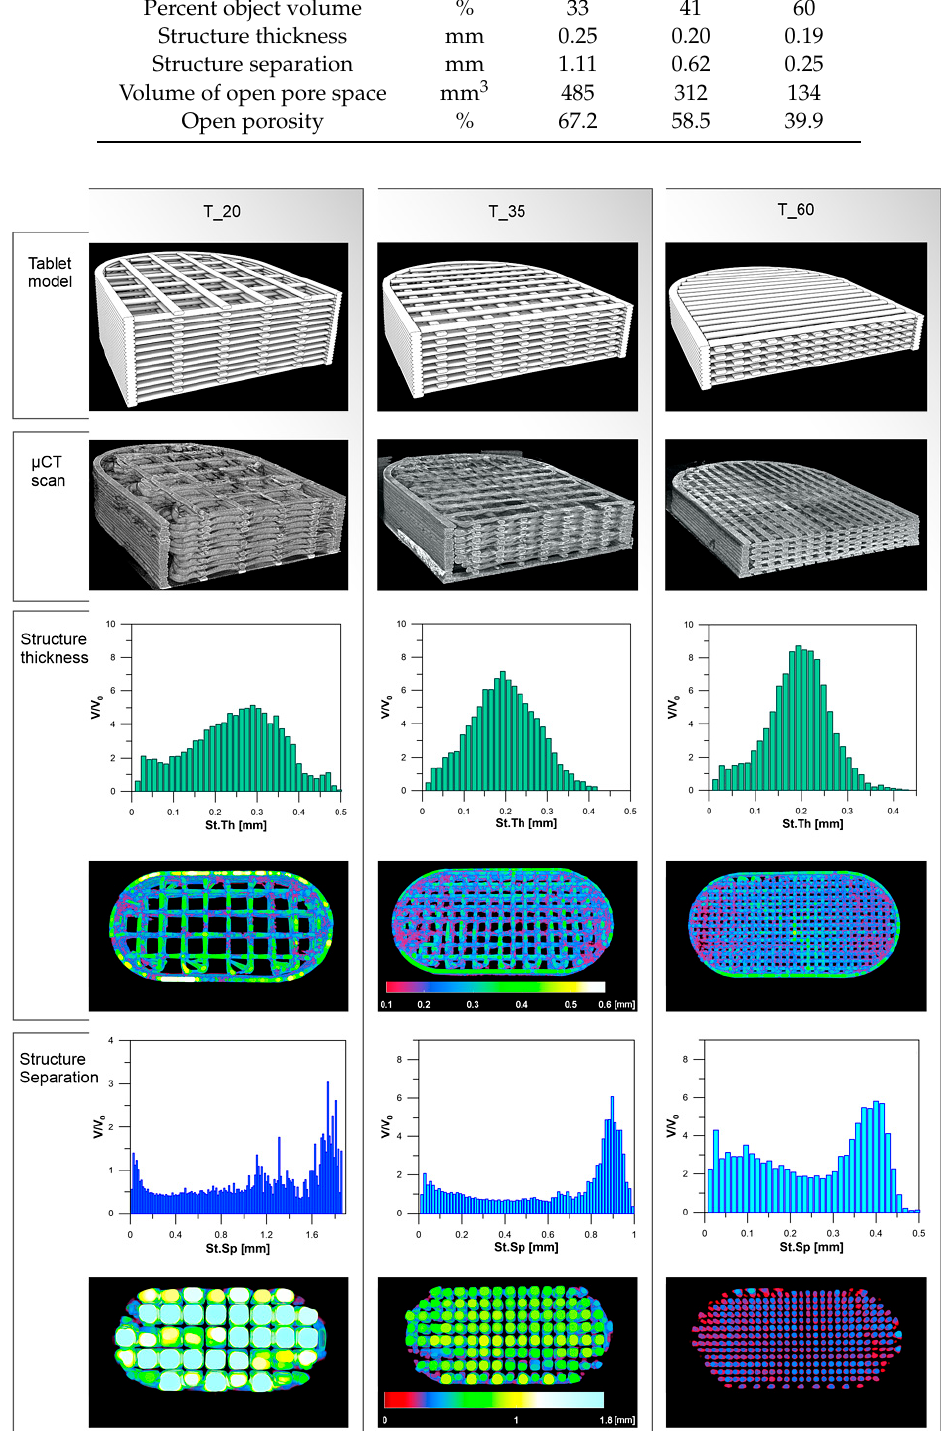
Figure 6. 3D tablet models, μ -CT scan images of 3DP tablets, and structure thickness and structure separation of 3DP tablets.